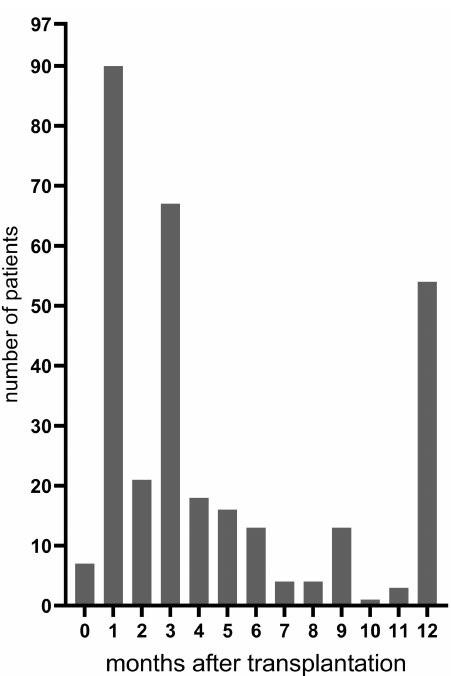
Figure 2. Time points of performed bronchoscopies after